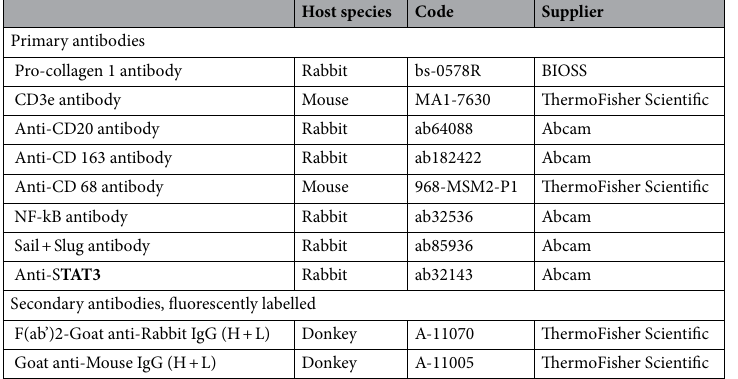
Table 2. Primary and secondary antibodies utilized for